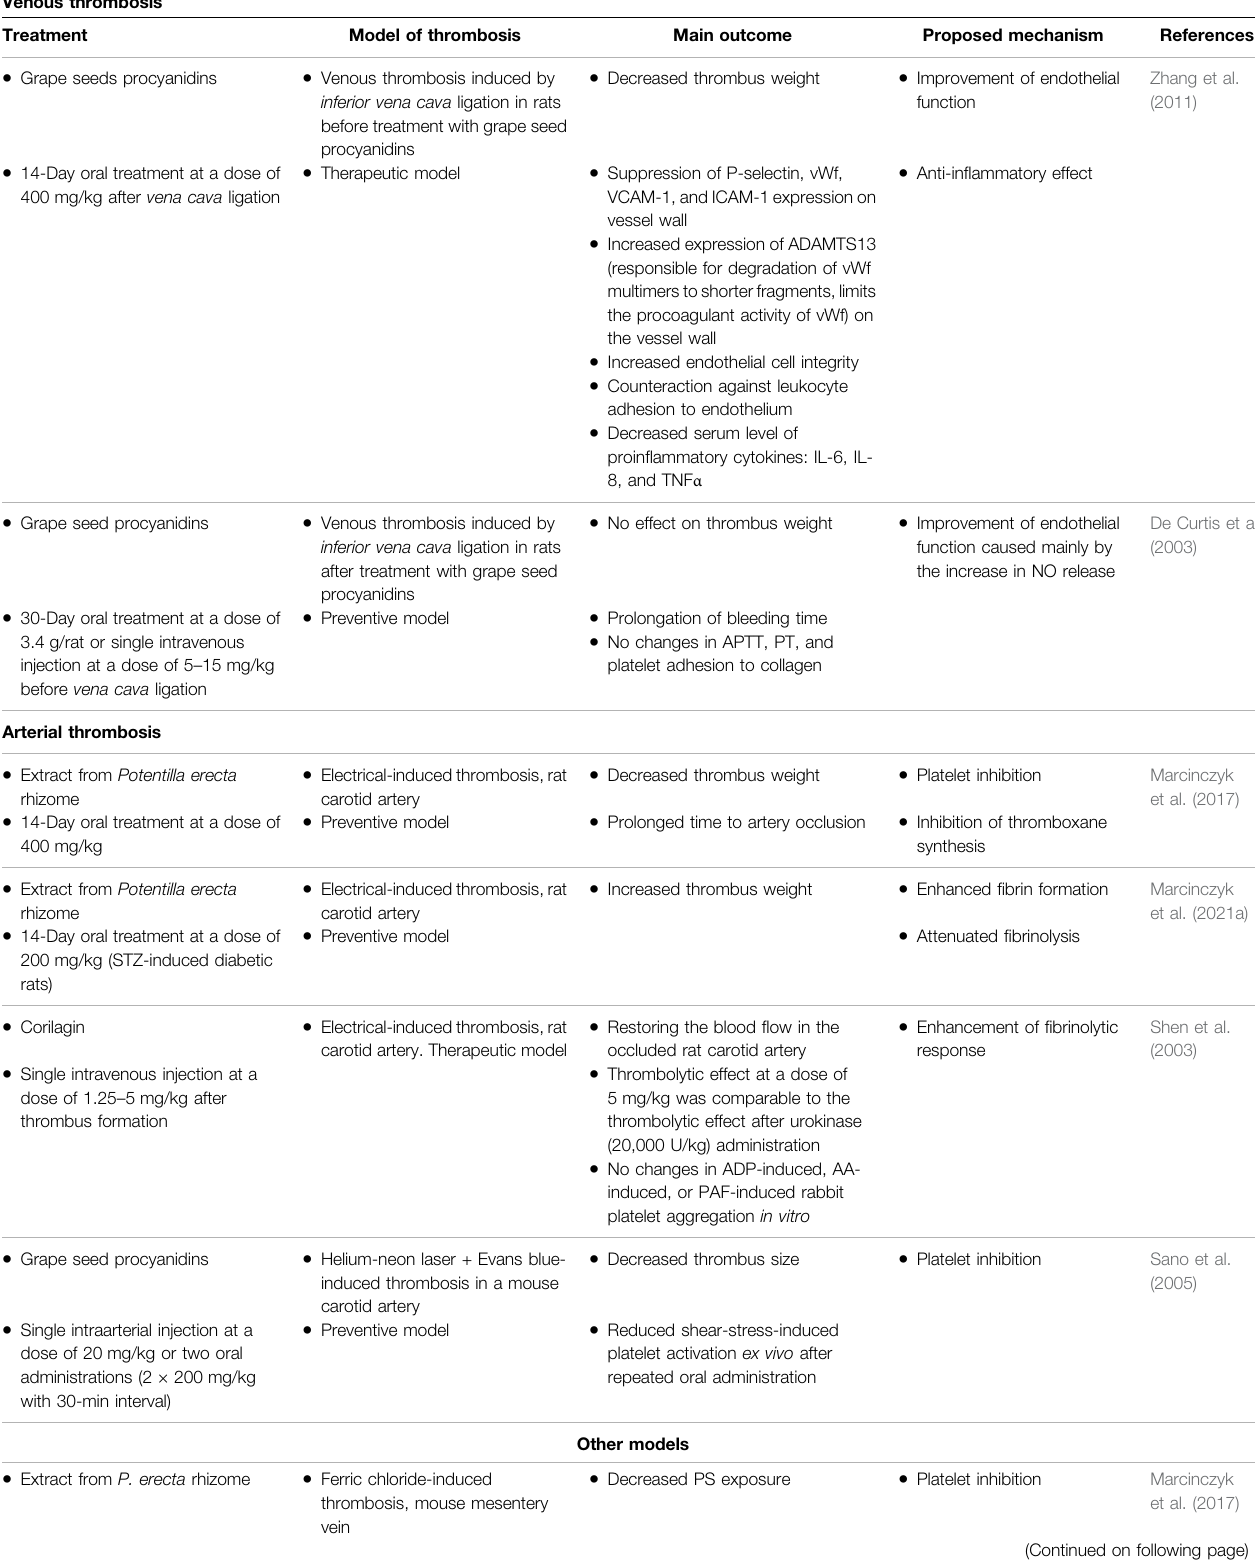
TABLE 3 | Effect of tannins on experimental models of thrombosis. Venous